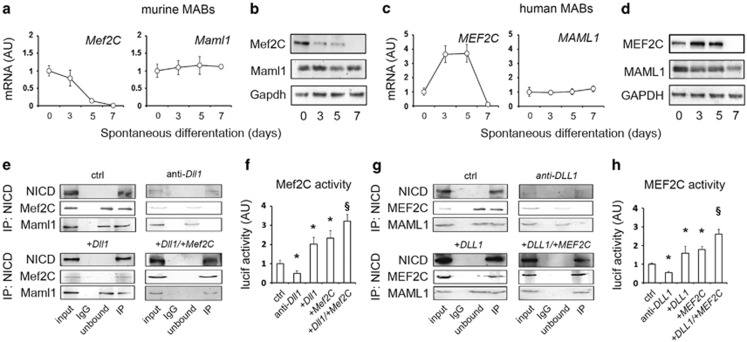
Dll1-triggered Notch signaling in MABs interplays with Maml1 and Mef2C and results in increased Mef2C activity. (a–d) Expression and protein levels of Mef2C/MEF2C and Maml1/MAML1 in murine and human MABs over time during spontaneous differentiation in vitro. Expression levels are reported in arbitrary units (AU) as fold change versus day 0. (e) Results of NICD-based immunoprecipitation (IP-NICD) at day 3 of differentiation of murine MABs in control conditions (ctrl), and in conditions of Dll1 knock-down (anti-Dll1), Dll1 overexpression (+Dll1), and combined overexpression of Dll1 and Mef2C (+Dll1/+Mef2C). Input, protein extract; IgG, mouse IgG-based IP, negative control; unbound, unbound fraction after IP. (f) Luciferase activity assayed at day 5 of differentiation after transfection with a plasmid carrying firefly luciferase expression under the control of a Mef2C-responsive element into murine MABs after Dll1 silencing (anti-Dll1), Dll1 overexpression (+Dll1), Mef2C overexpression (+Mef2C), and combined overexpression of Dll1/DLL1 and Mef2C/MEF2C (+Dll1/+Mef2C). *P<0.05 versus ctrl; §P<0.05 versus +Dll1/+DLL1 and +Mef2C/MEF2C (n=4). Depicted in (g, h) are the analogous results obtained with human MABs. Luciferase activity levels are reported in AU as fold change of renilla-normalized values versus ctrl conditions. Control cells were transduced with scramble and overexpression vectors and kept doxycycline-free. Data in charts are depicted as mean±standard deviation of ≥3 independent experiments. Scale bars indicate 100 μm